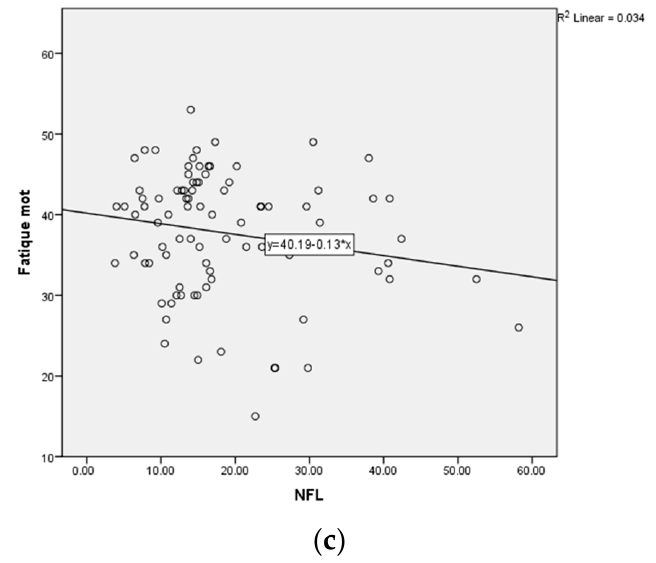
Figure 3. ( a – c ) Correlation by Spearman-Rho of circulating NfL level and fatigue severity in patients with positive anti-NR2 antibody titer (>2 ng/mL).